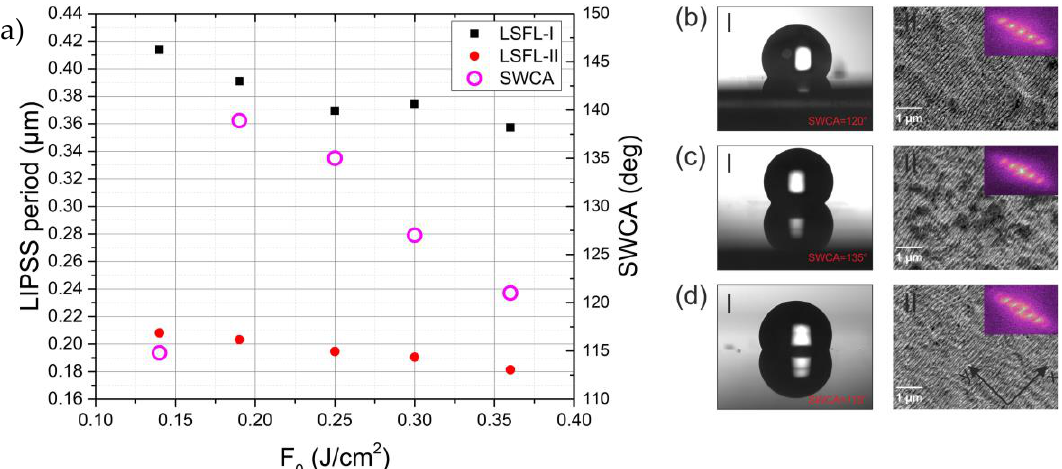
Figure 5. ( a ) Dependence of the LIPSS period and SWCA of the samples prepared using beam array area hatching, on the laser fluence F 0 . ( b – d ) Images of the water droplets ( I ) and SEM micrographs ( II ) on the surfaces textured using F 0 = 0.12 J/cm 2 , 0.25 J/cm 2 , and 0.36 J/cm 2 , respectively (h = 1.8 µm was equal for all samples); insets in the SEM micrographs show their 2D-FFT images.